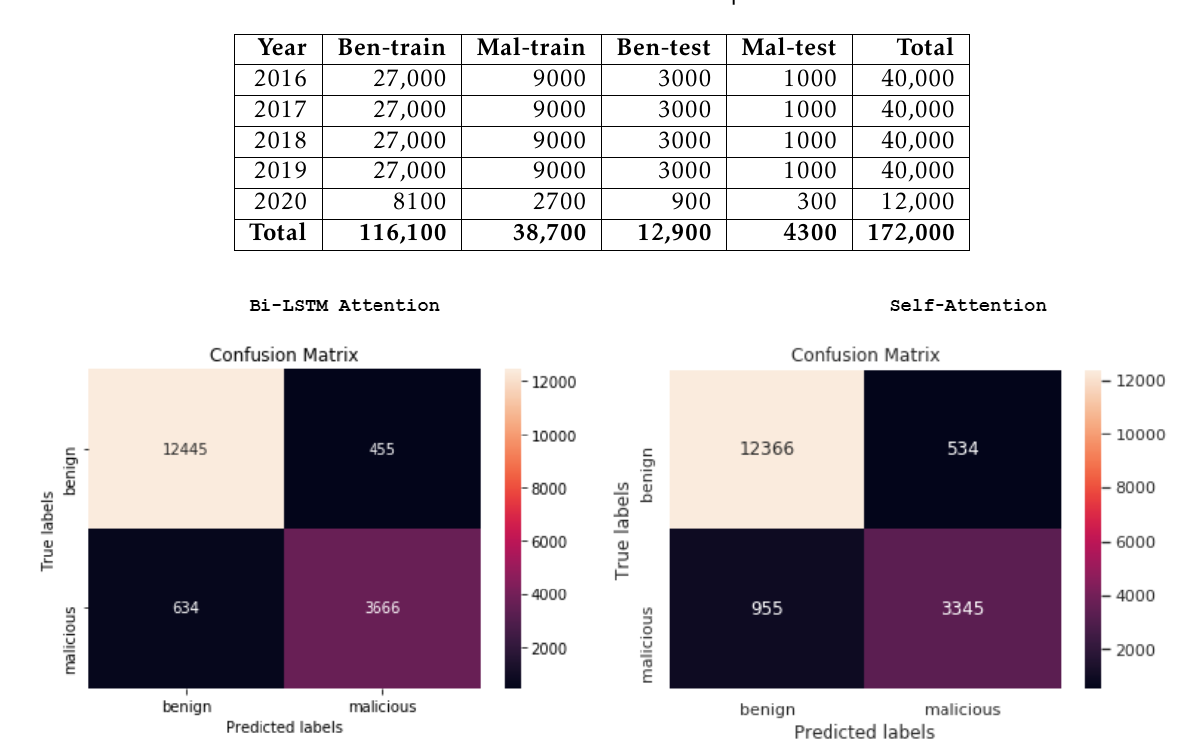
Table 3. The train-test data split